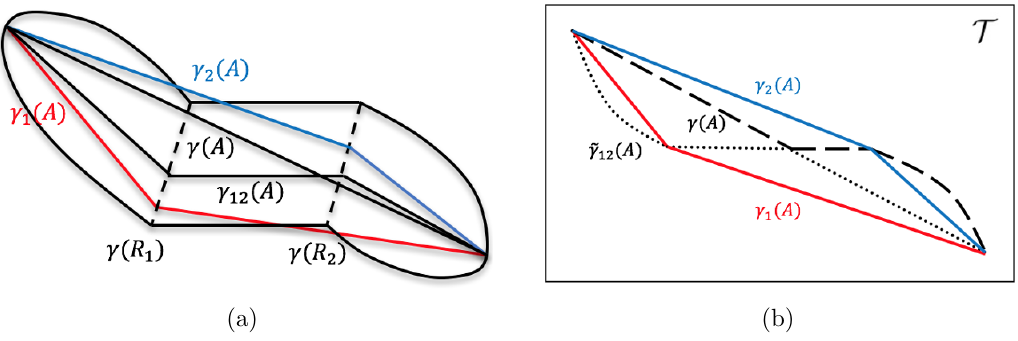
Figure 20. This is the case for destructive interference. In (b) we see how we can apply the SSA proof to this situation by projecting the surfaces (cid:13) 12 to the same slice where (cid:13) 1 ; (cid:13) 2 ; (cid:13) are. We recombine (cid:13) and the projected surface ~ (cid:13) 12 into the dashed part and the dotted part. The length of the dashed part is less than (cid:13) 2 and the length of the dotted part is less than (cid:13) 1